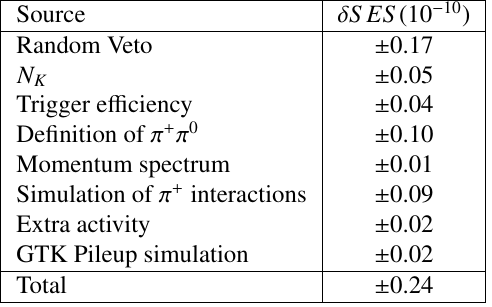
Table 2. Summary of the expected number of signal and background events in the signal regions R1 and R2 for the 2016